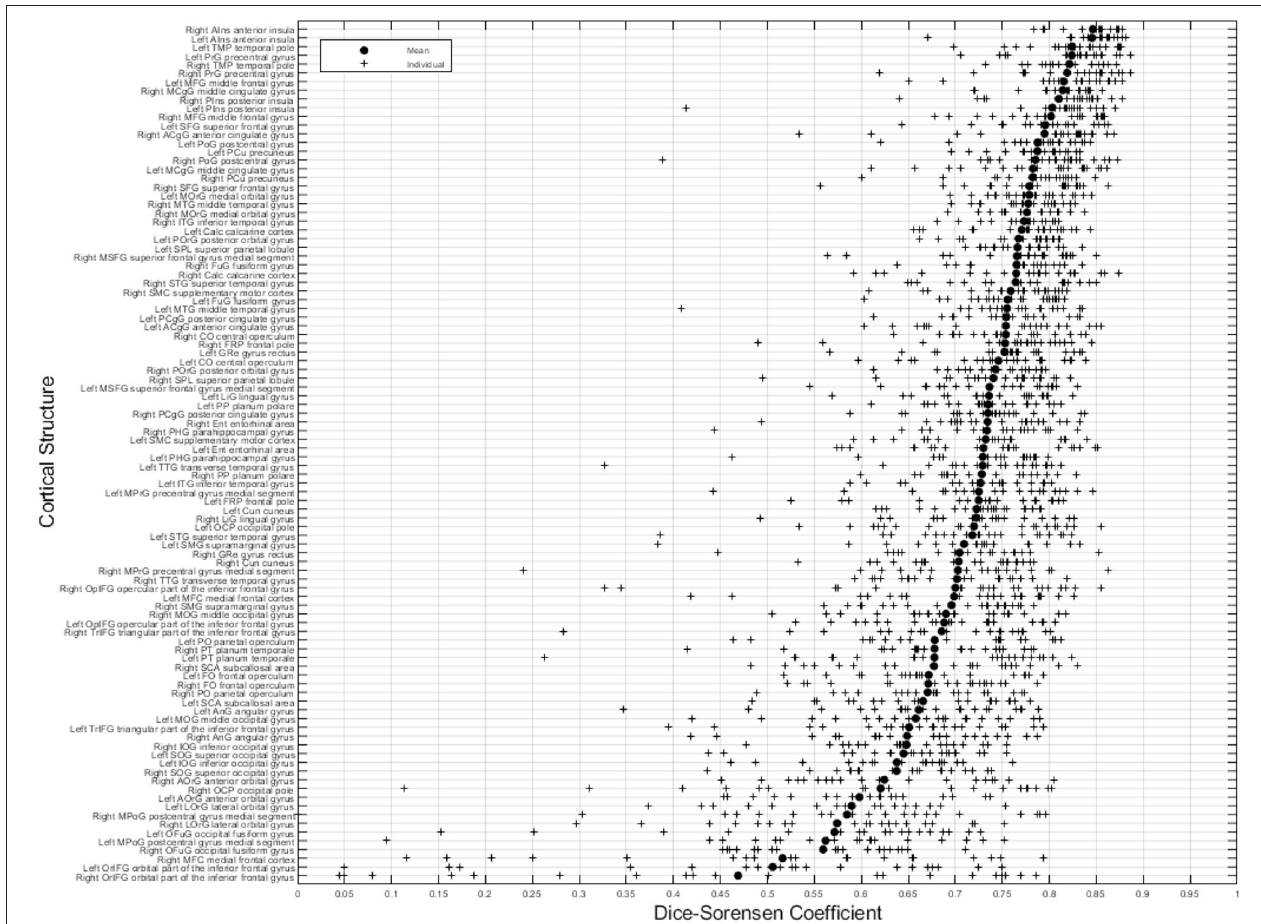
FIGURE 10 | DSC for cortical brain regions (fusion challenge data). Plots show individual DSC ( + ) as well as average DSC ( • ) across subjects for each